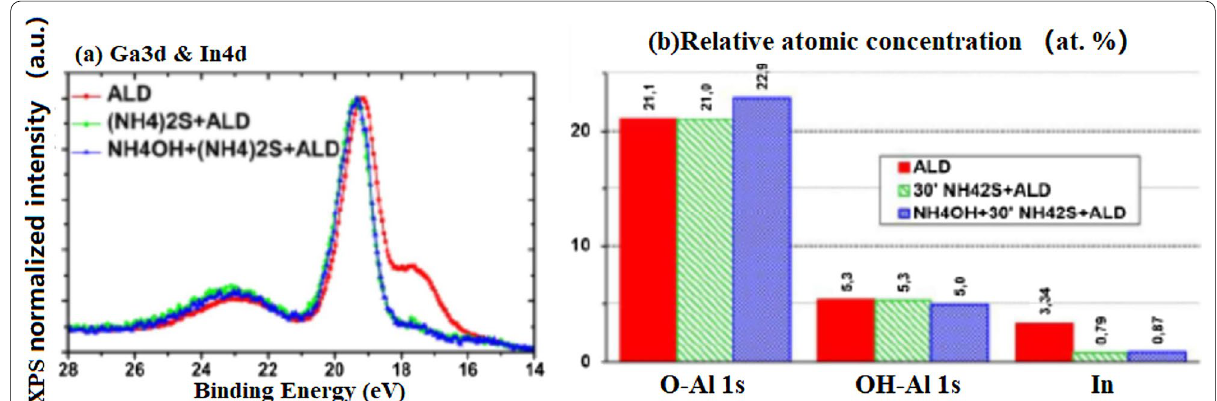
Fig. 15 a Superposition of normalized Ga3d‑In4d spectra for ALD and PEALD samples without, with a 30’ (NH 4 ) 2 S or with a NH 4 OH surface treatment, b proportion of O1s components and total indium contribution using In4d line